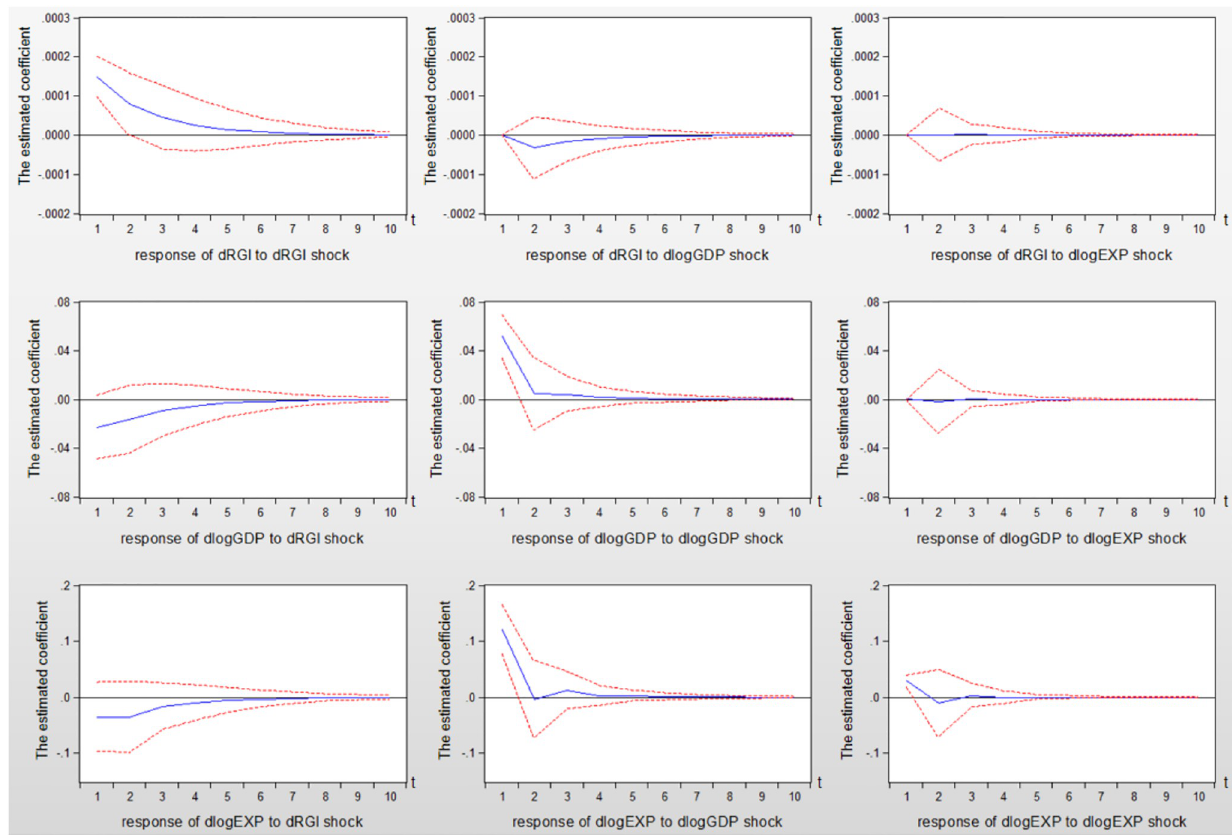
Fig 1. Impulse response diagram of the time series VAR